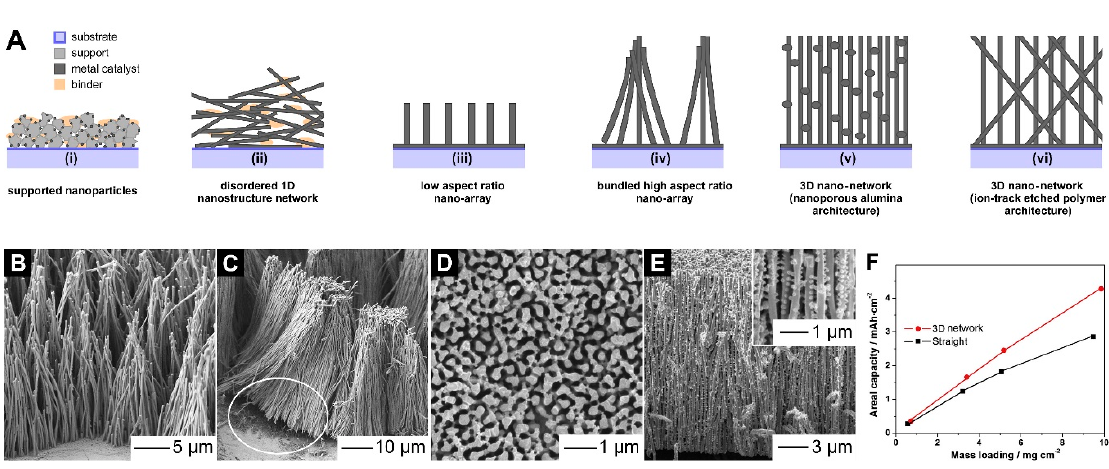
Figure 7. ( A ) Scheme of different catalyst layer architectures discussed throughout this work. ( B – E ) Different Ni-Sn nanowire architectures obtained by electrodeposition in nanoporous anodized alumina. ( B ) Moderate bundling of 20 µ m long nanowires. ( C ) Pronounced bundling of 40 µ m